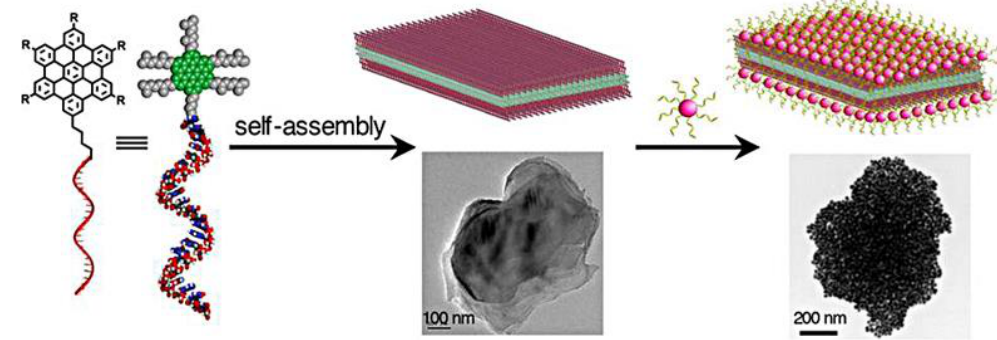
Figure 3. Illustration of the self-assembly of the amphiphilic DNA covalent with hexa-peri-benzocoronene tethered with alkyl chains. The amphiphiles assembled into 2D DNA nanosheets decorated with DNA sequences, which could further hybridize with complementary DNA modified gold nanoparticles. The green color indicates the hexa-peri-benzocoronene and the grey chains indicate the alkyl chains. Reproduced with permission from the authors of a previous paper [50]. Copyright 2017 American Chemical Society.